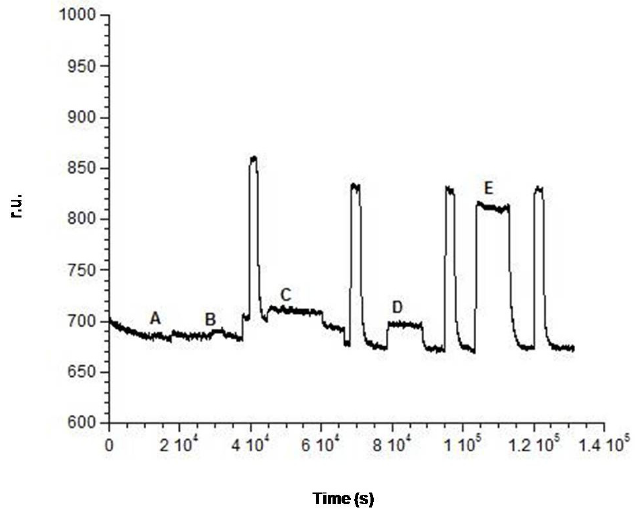
Figure 10. Selectivity: complexation of penicillin G by using sandwich immunosensor format.